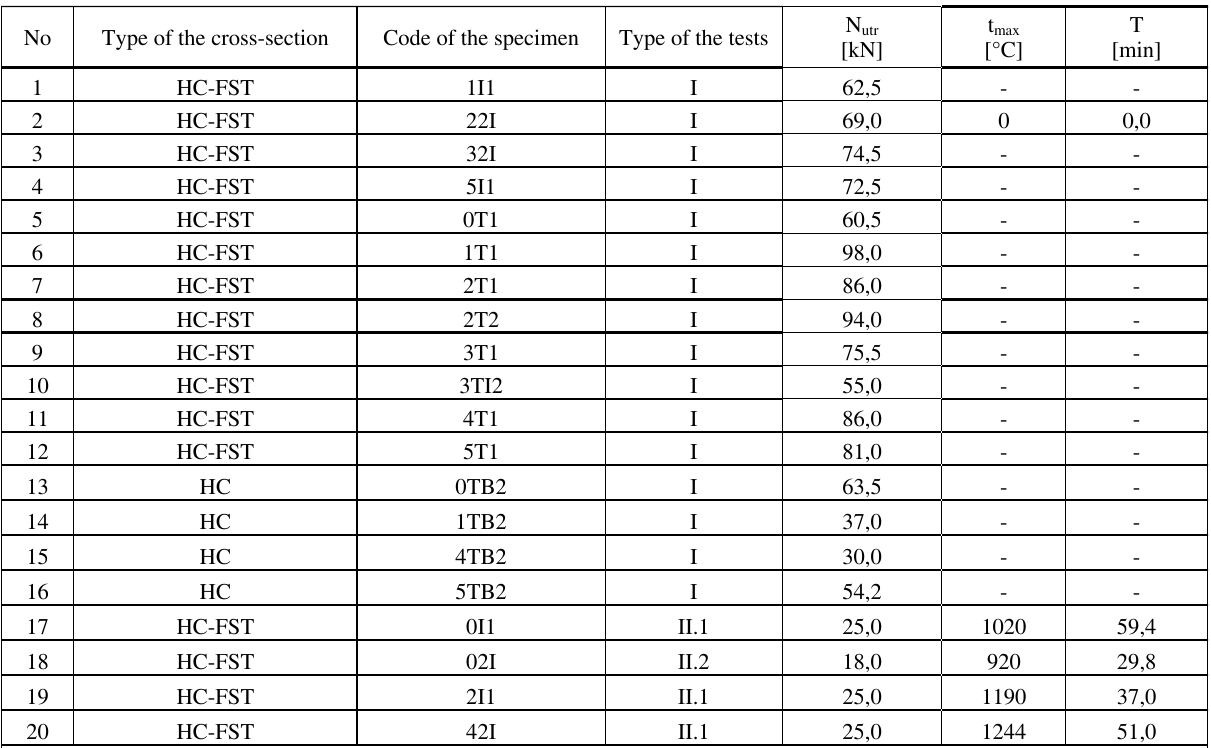
The meanings of the markings of the table columns: N utr – the trial load-bearing capacity for axially loaded specimen, t max – the maximum temperature of the furnace reached during the fire resistance test, T – the duration of heating during the fire resistance